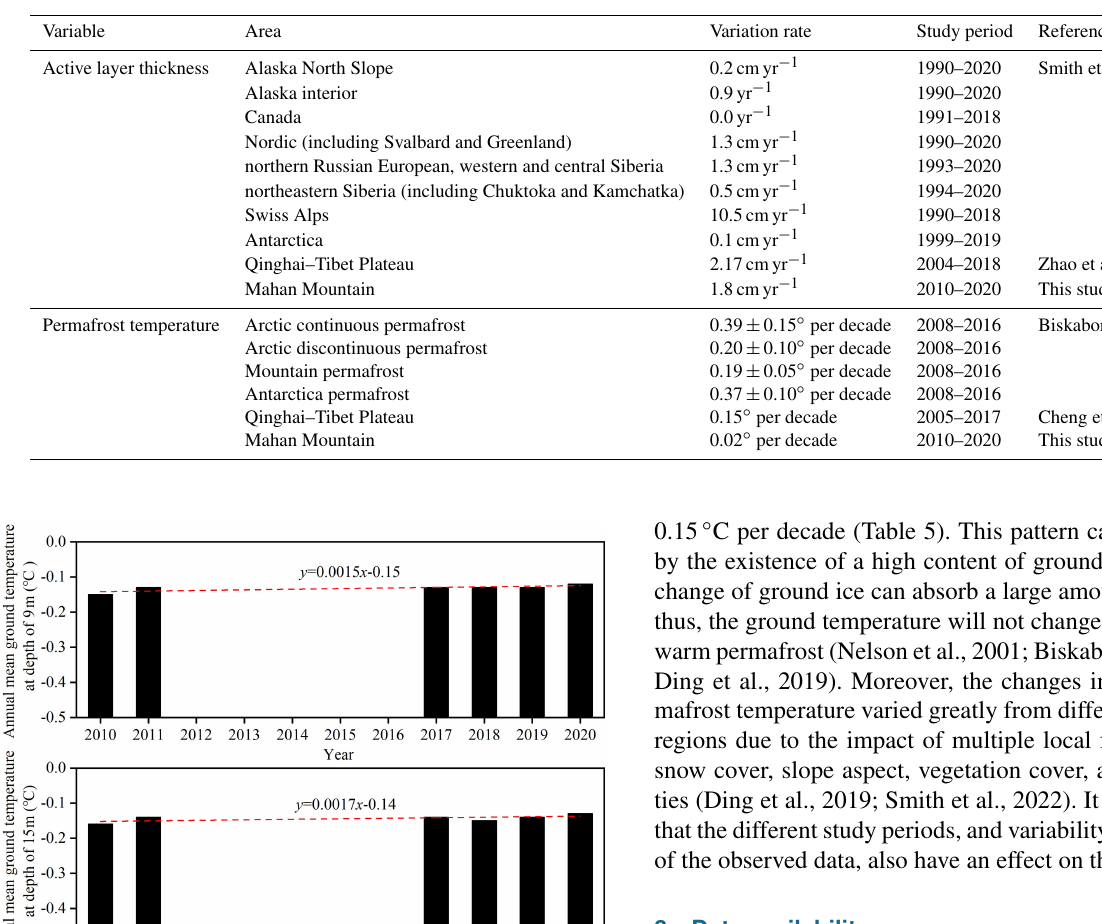
Table 5. Comparison of the change rates of active layer thickness (ALT) and permafrost temperature in different permafrost regions.